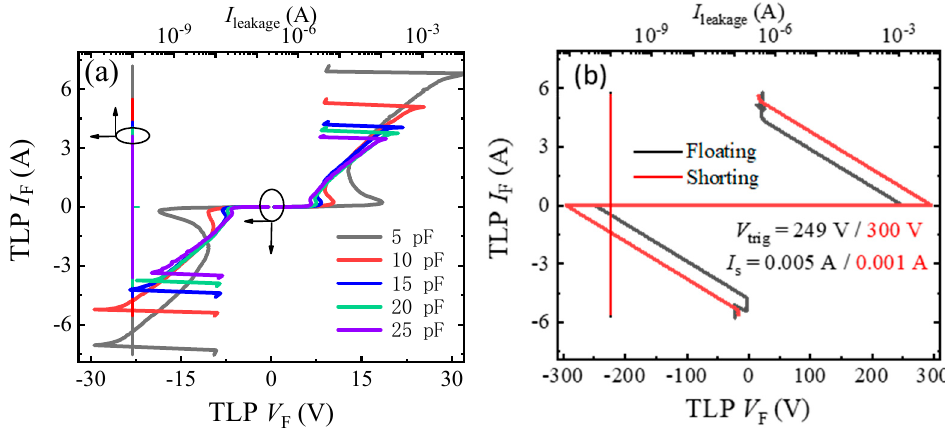
Figure 5. The bidirectional TLP I–V characteristics of the proposed AlGaN/GaN B-ESD-PD with different C GA ( C GC ) values ( a ), and the gate-floating and GS-shorting bidirectional GaN diodes ( b ).